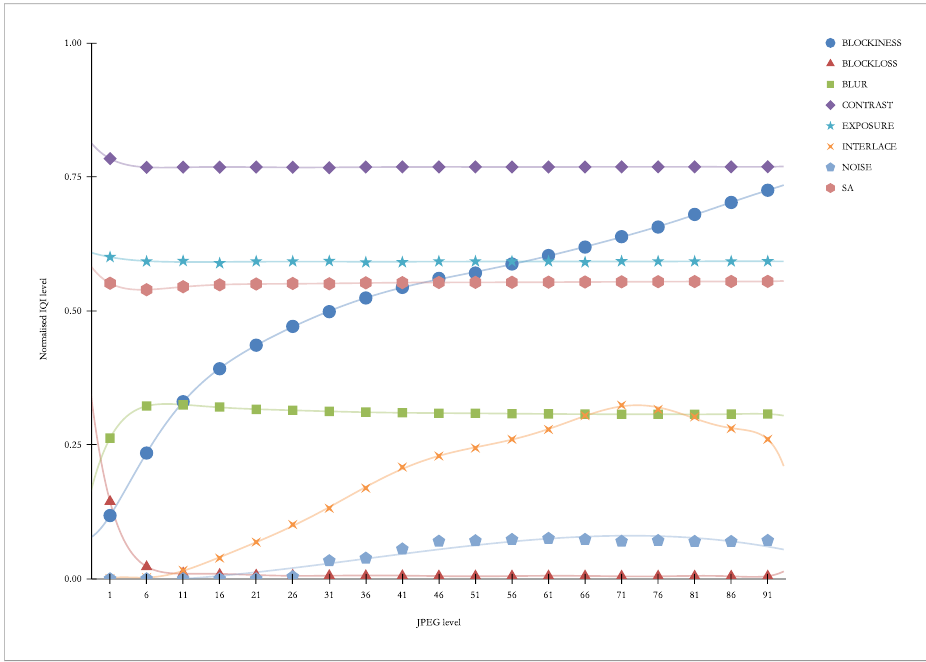
Figure 21. “Our” indicators vs. JPEG [quality units].